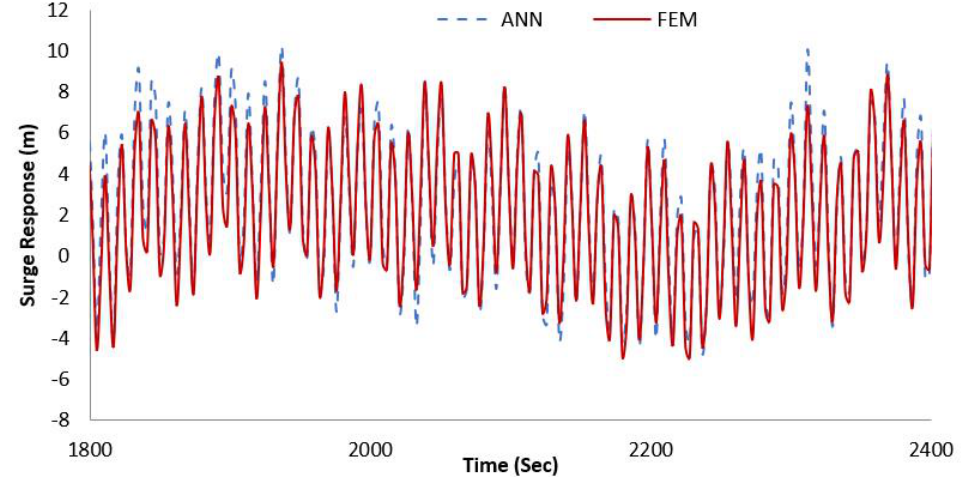
Figure 6. The surge response time history predicted by the training data of the ANN and FEM results for 11.39 s wave period and 12.65 m wave height.